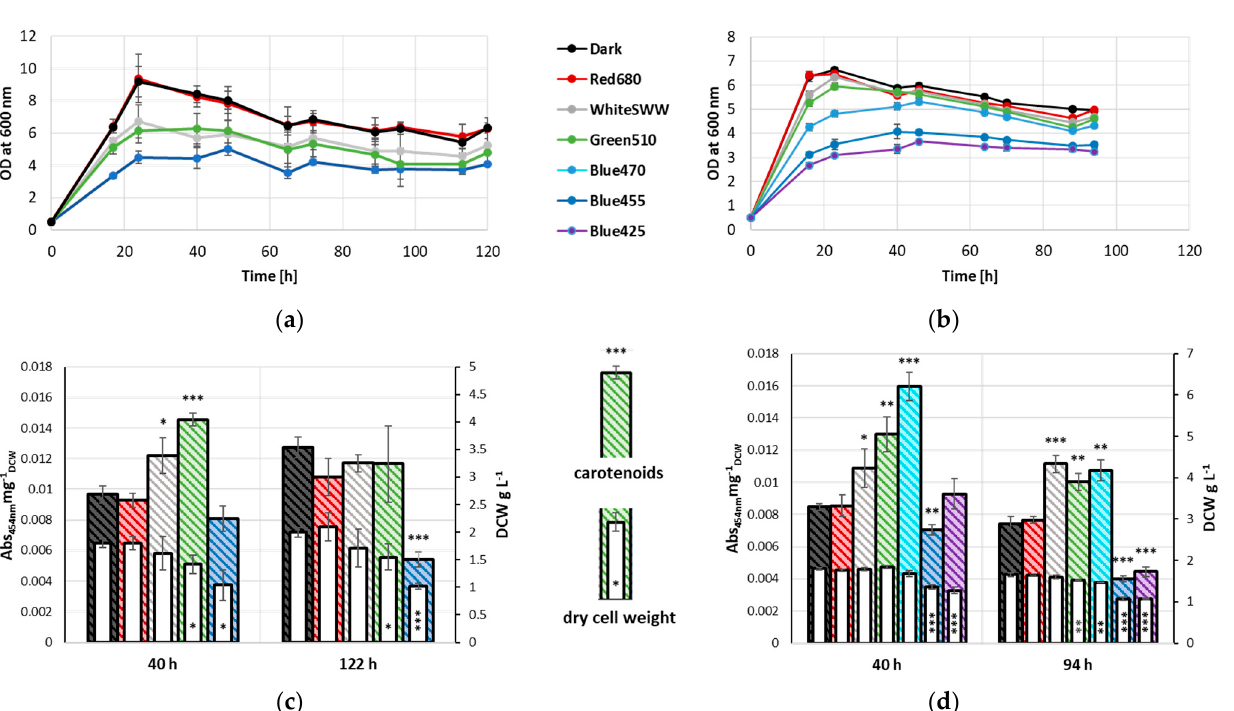
Figure 1. Growth of R. erythropolis measured as OD at 600 nm at 236 W s − 2 illumination with white (standard warm white), blue (455 nm), green (510 nm) and red (680 nm) light as well as control cultivated under exclusion of light, n = 3. ( a ) Growth for 122 h. ( b ) Growth for 94 h with two additional wavelengths (425, 470 nm) of blue light; biomass formation (dry cell weight) and carotenoid accumulation (normalized to dry cell weight) of R. erythropolis at 236 W s − 2 illumination with white (SWW), blue (455 nm), green (510 nm) and red (680 nm) light as well as a control, * p < 0.05, ** p < 0.01, *** p < 0.001 (t-tests evaluated against respective non-illuminated control), n = 3. ( c ) Biomass formation and carotenoid accumulation of R. erythropolis at 40 h and 122 h. ( d ) Biomass formation and carotenoid accumulation of R. erythropolis at 40 h and 94 h with two additional wavelengths (425, 470 nm) of blue light.